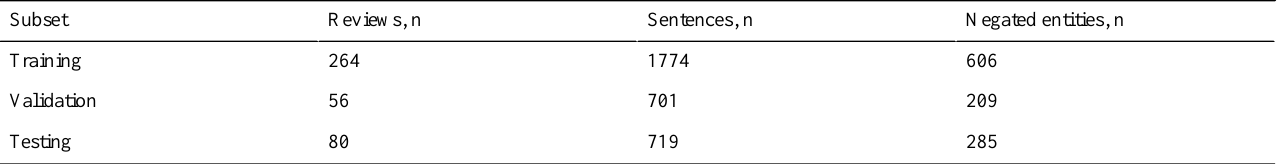
Table 12. SFU ReviewSP-NEG data sets.